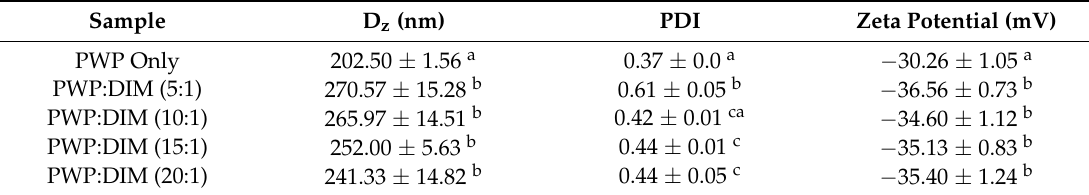
Table 1. Effects of different DIM to polymerized whey protein ratios on particle size, polydispersity index (PDI), zeta